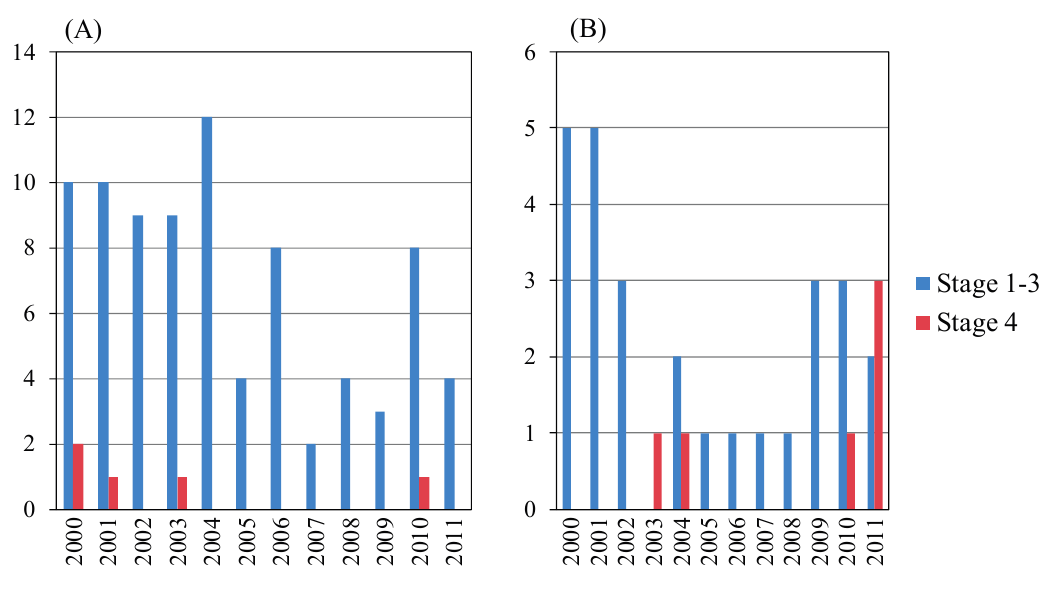
Figure 2. Scheuer stage of primary biliary cirrhosis (PBC) patients according to age. ( A ) Age <65 (years) ( n = 91); ( B ) Age ≥ 65 (years) ( n =